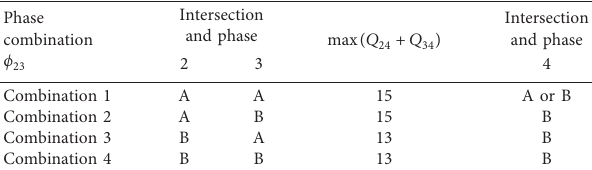
′ . Table 3: Combination forms for arg max ( Q 23